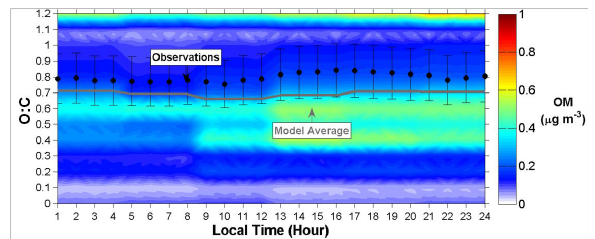
Figure 6. Diurnally averaged O:C for a representative day during the FAME-08 campaign assuming an initial O:C that varies with volatility for first-generation organic products of VOC oxidation in the 2D-VBS.